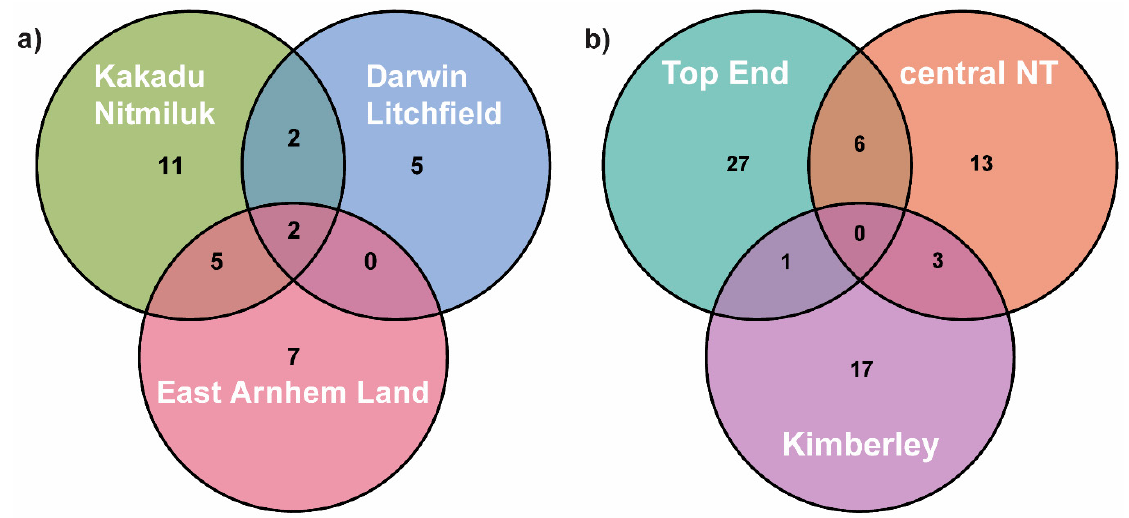
Figure 10. Species overlap among subregions within ( a ) the Top End of the NT, and ( b ) major regions in north-western Australia. Data are numbers of unique and shared species represented by the sequenced specimens.